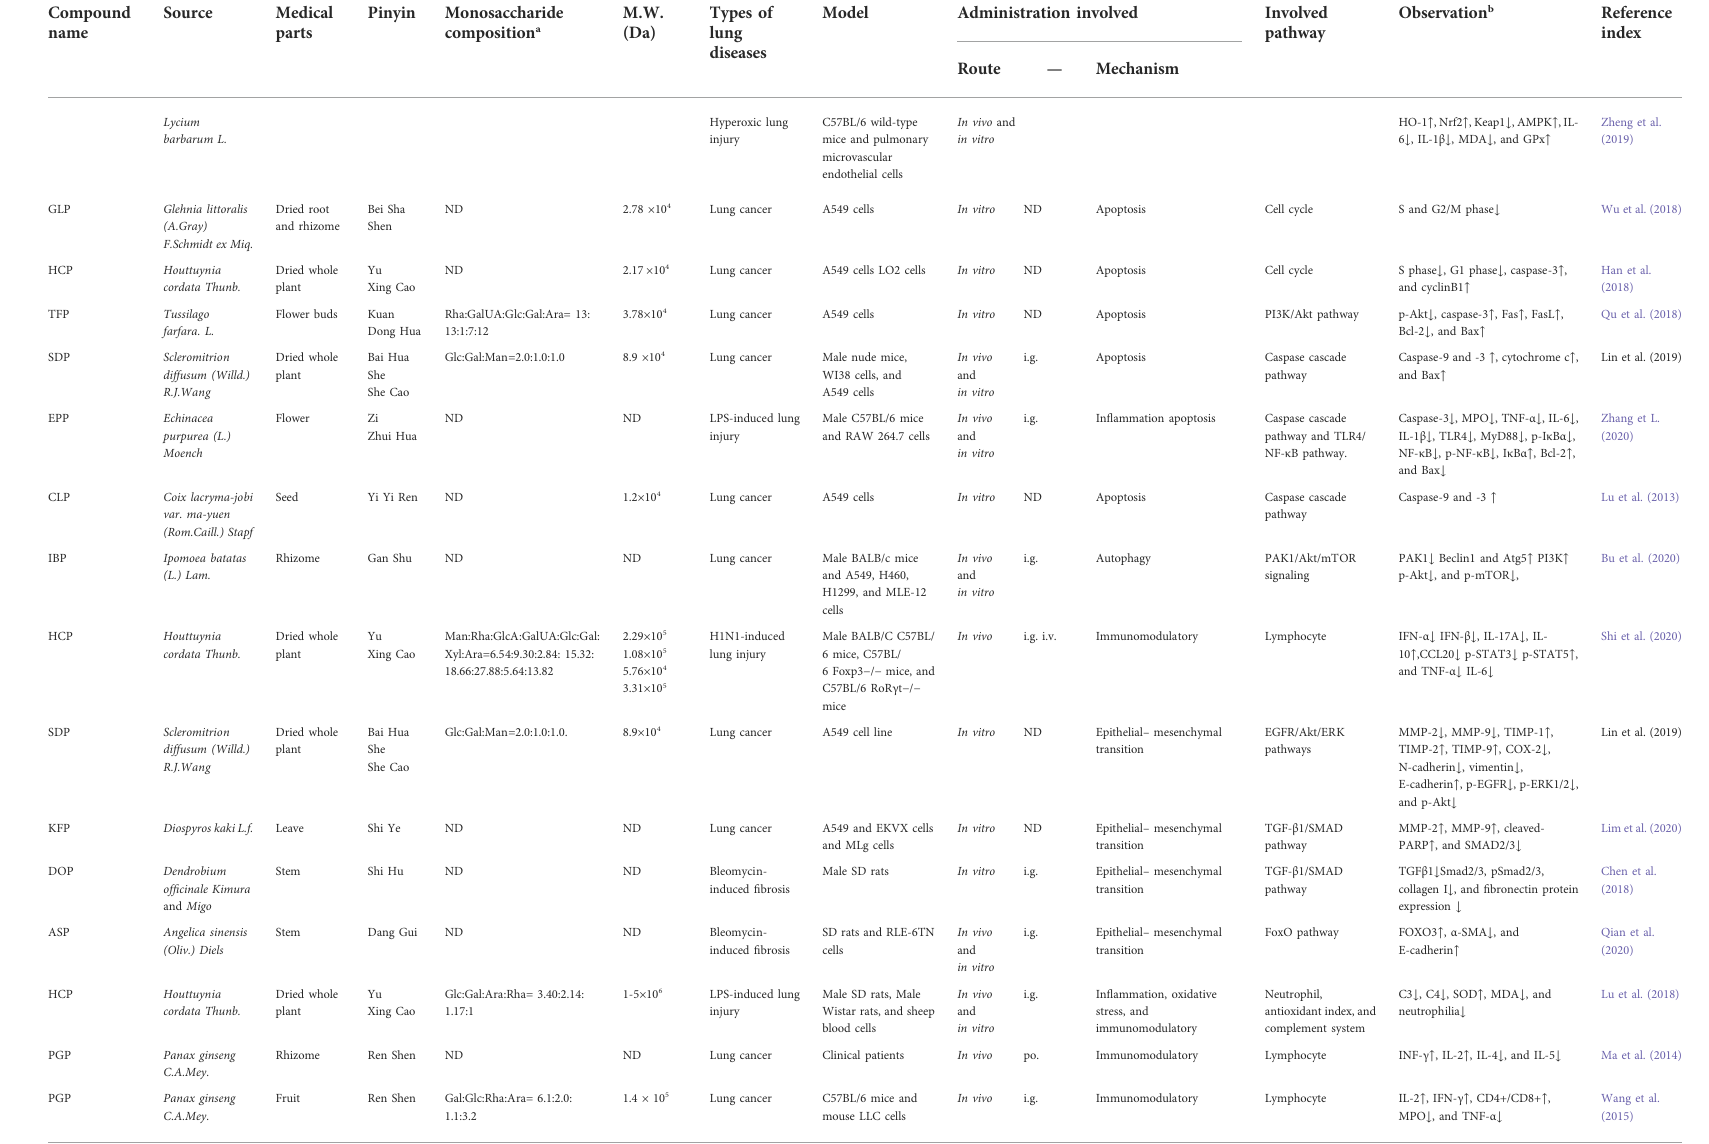
TABLE 1 ( Continued ) Underlying protective mechanisms of plant polysaccharides against lung